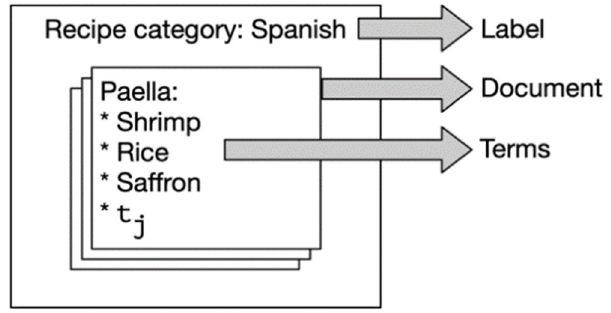
Figure 3. Different levels of a recipe formalized as their corresponding features.